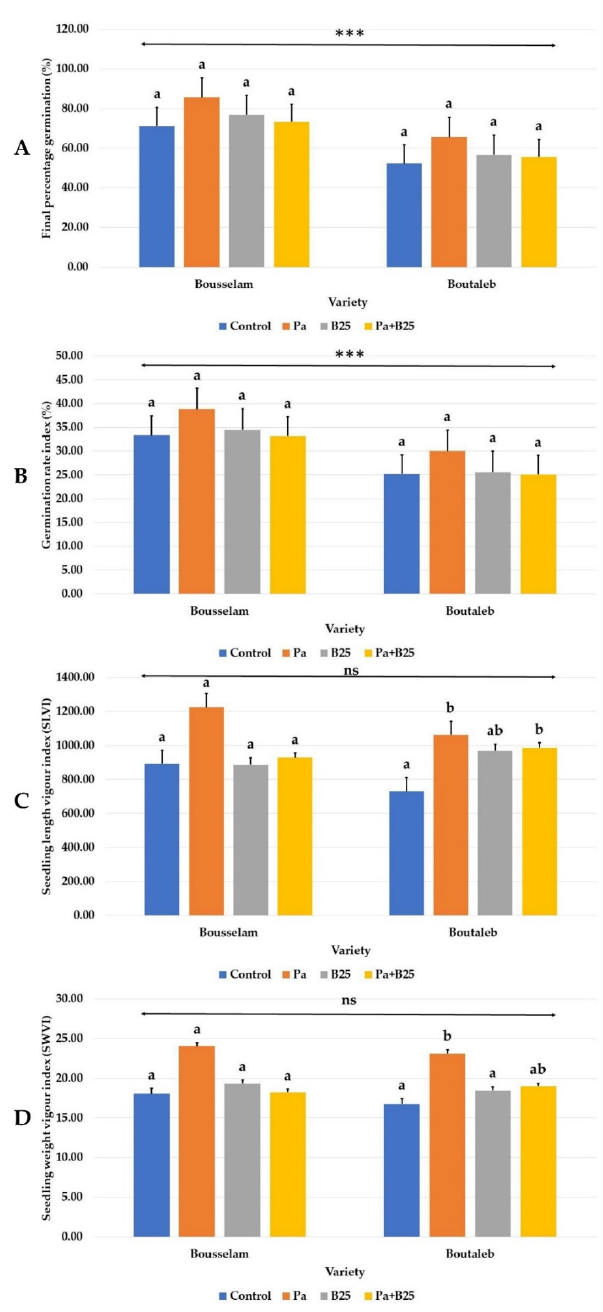
Figure 1. Effect of bacterial inoculation on ( A ) final percentage germination (%), ( B ) germination rate index (%), ( C ) seedling length vigor index, and ( D ) seedling weight vigor index of the two wheat varieties, Bousselam and Boutaleb. The bar plots represent the mean ± standard error of three different experiments. IBM SPSS Statistics v.24 was used to perform statistical analysis, using a two-way ANOVA and Tukey’s multiple comparison post-test. Significant differences are displayed as: *** p < 0.001. ns: non-significant.